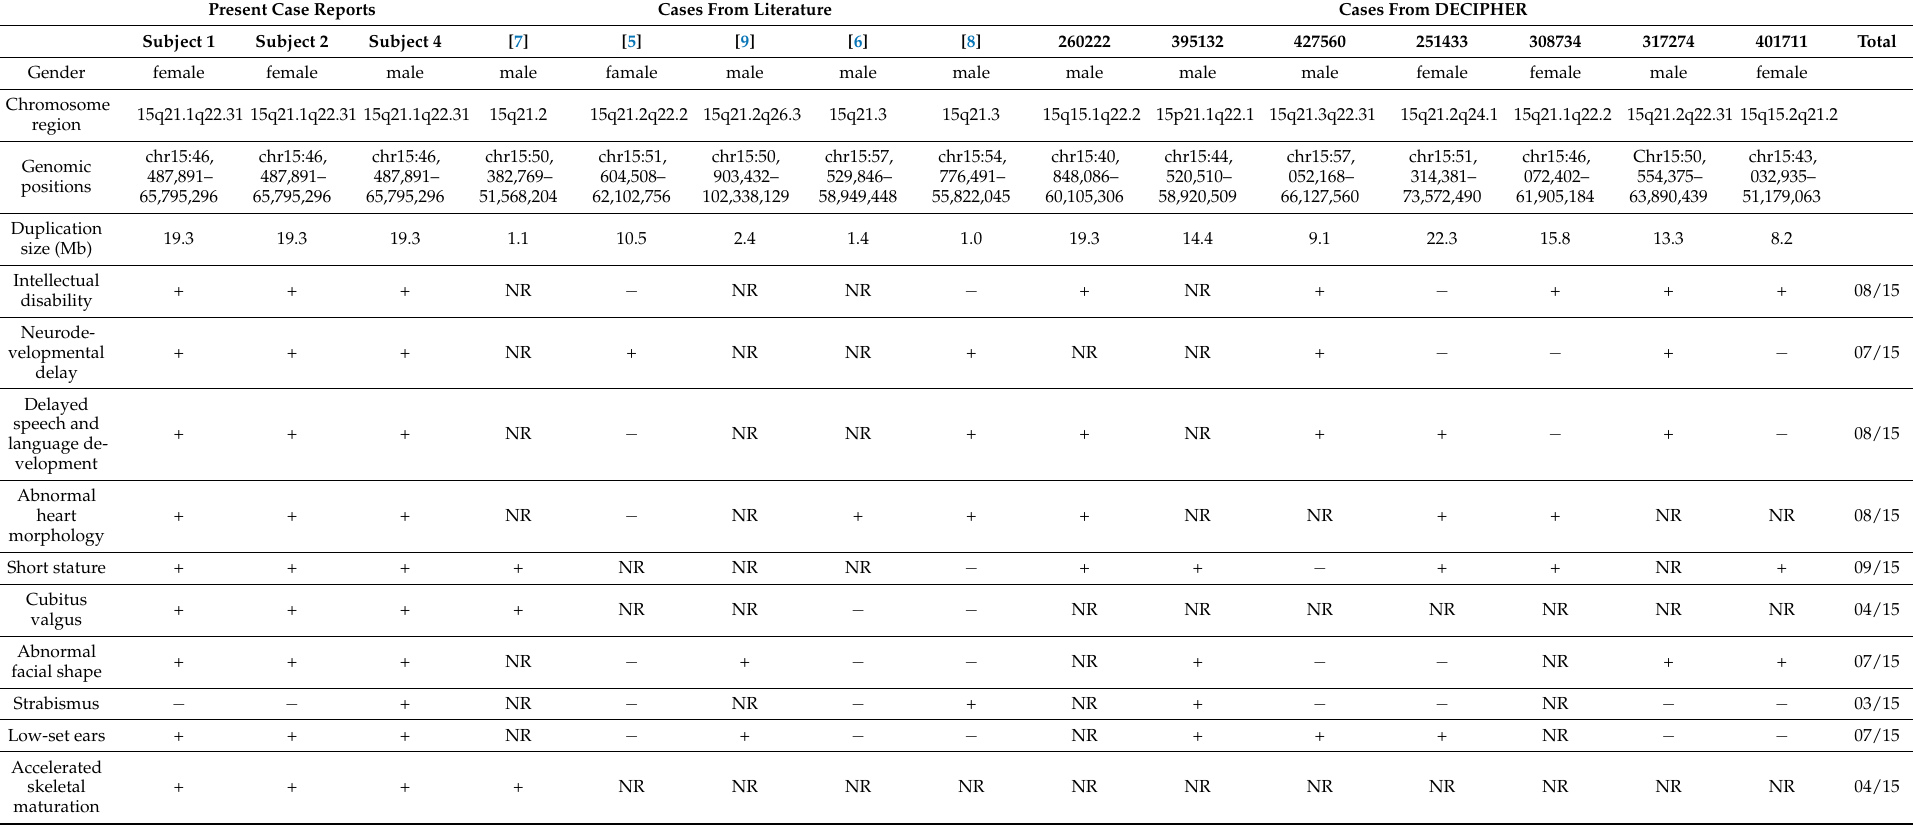
Table 1. Main clinical features of patients with duplication between the 15q15.1-q26.3